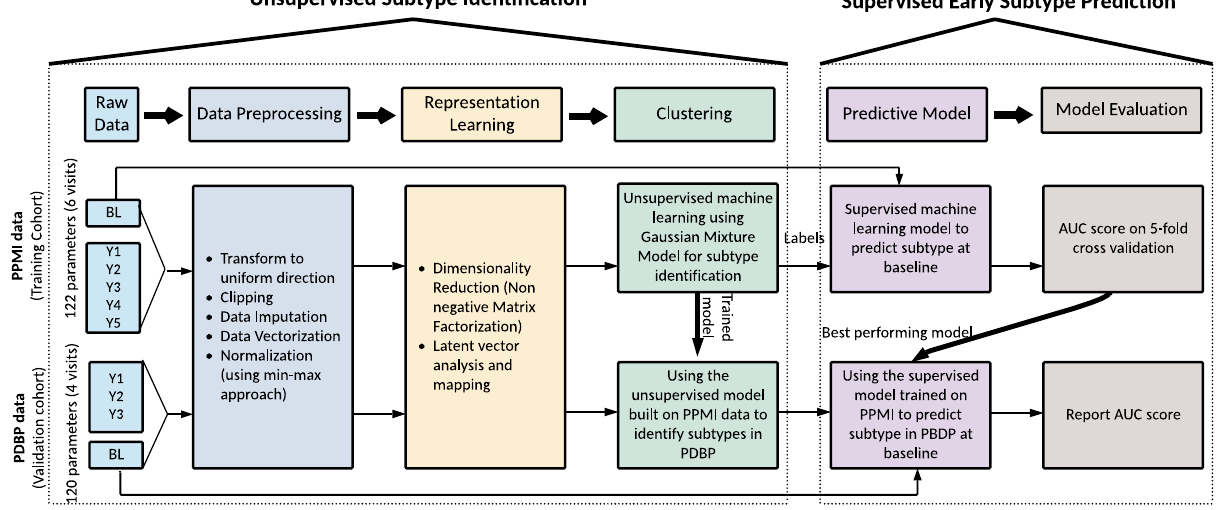
Fig. 1 Work fl ow of analysis and model development. PPMI Parkinson ’ s Progression Marker Initiative, PDBP Parkinson ’ s Disease Biomarkers Program, BL Baseline, Y1 Year1, Y2 Year2, Y3 Year3, Y4 Year4, Y5 Year5, AUC Area under receiver operating characteristic